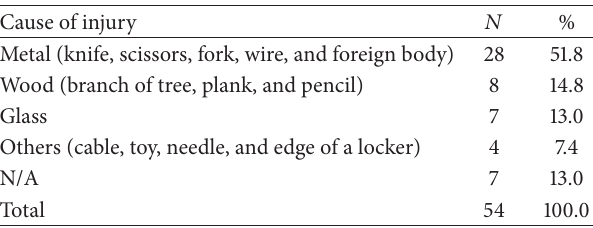
Table 2: Subjects that cause open globe injuries. Cause of injury Metal (knife, scissors, fork, wire, and foreign